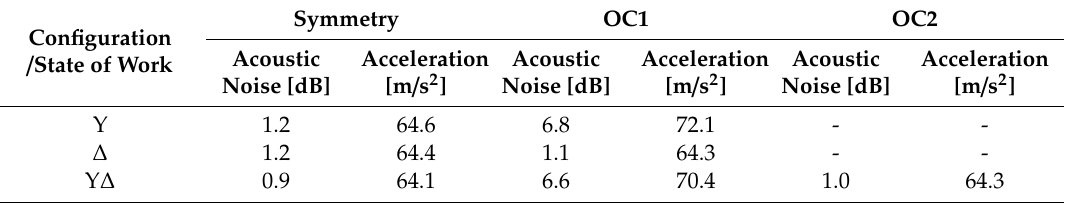
Table 3. Selected results for acceleration and noise